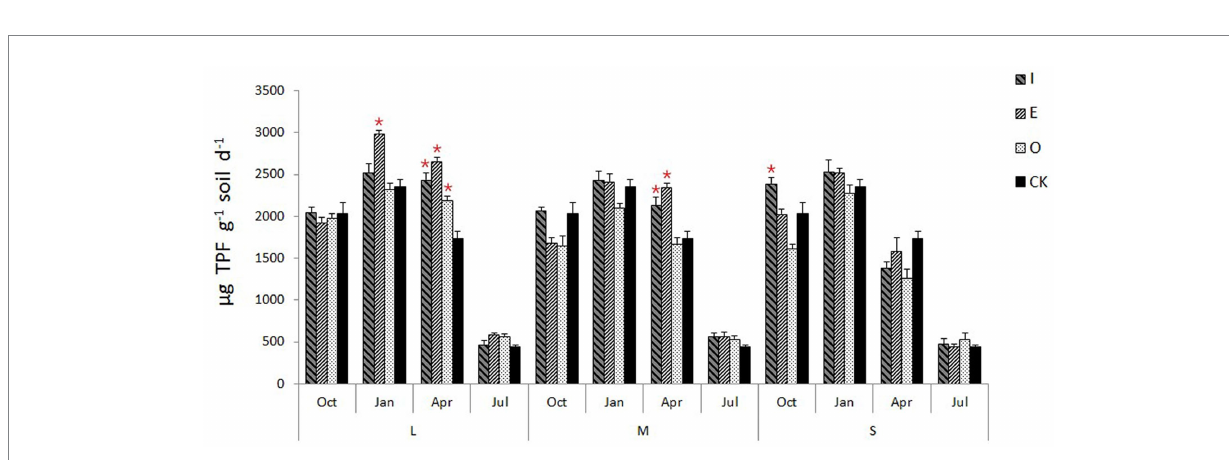
FIGURE 5 Soil dehydrogenase activity of different position in different sizes of gaps, the “*“signs represent significant